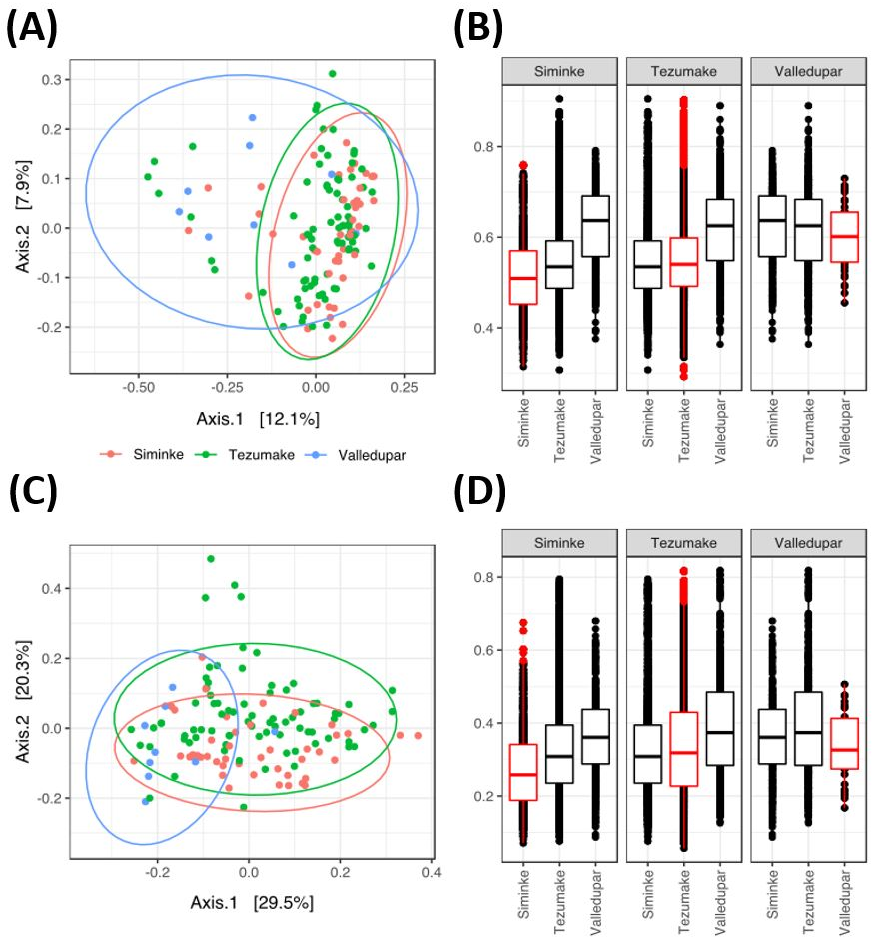
Figure 3. The Siminke and Tezumake microbiomes relative to that of the Valledupar population: ( A , C ) principal component analyses; ( B , D ) UniFrac distances among groups; ( A , B ) unweighted UniFrac distances; ( C , D ) weighted UniFrac.